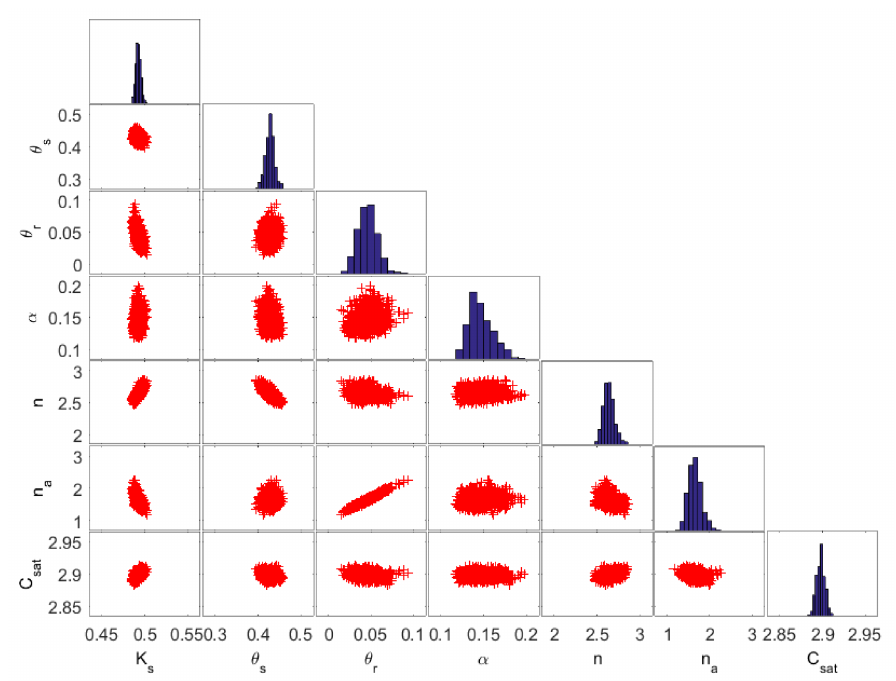
Figure 4. MCMC solutions in which all SP data are considered for the calibration. The diagonal plots represent the inferred posterior probability distribution of the model parameters. The off-diagonal scatterplots represent the pairwise correlations in the MCMC drawing.